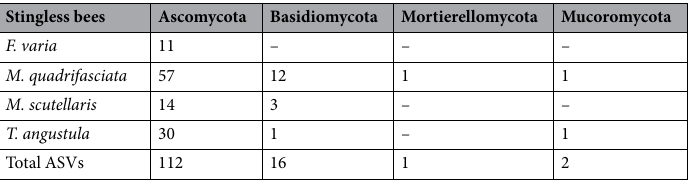
Table 3. Abundance of fungal phyla observed in F. varia , M. quadrifasciata , M. scutellaris , and T. angustula larval